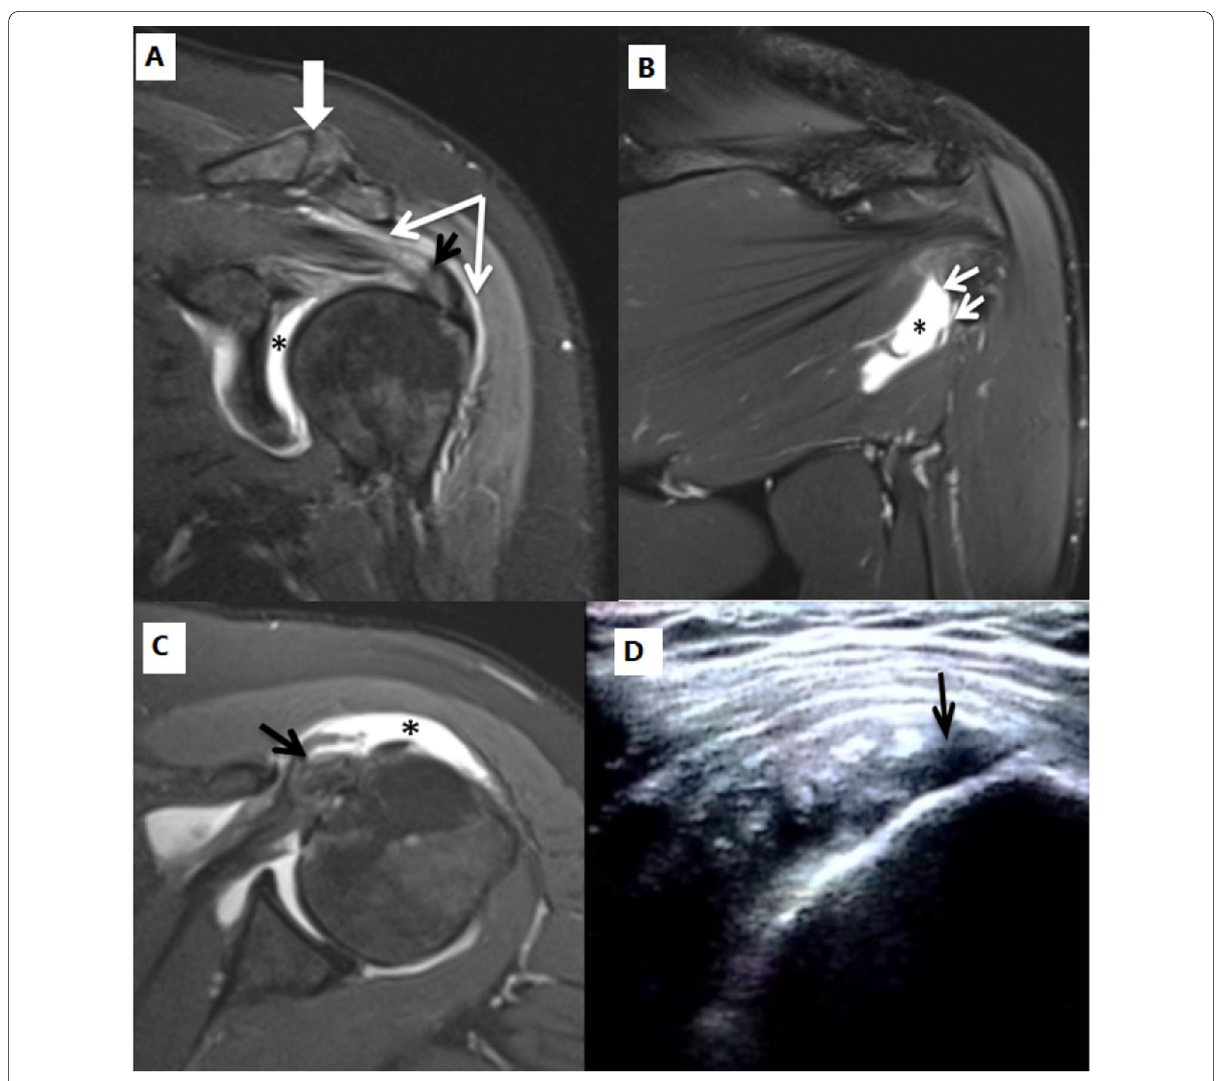
hypo‑echoic full‑thickness defect within the left supraspinatus tendon (black arrow) diagnostic of supraspinatus full thickness